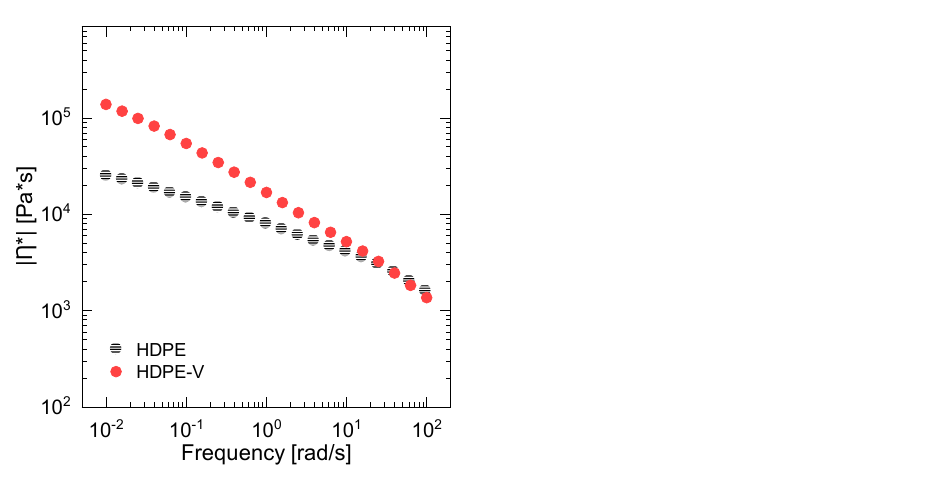
Figure 4. Complex viscosity | η ∗ | as a function of the frequency of HDPE and HDPE-V (220 ◦ C). Figure 4 also reveals the shear-thinning behavior of both polymers. The extent of shear thinning was estimated by fitting the data in Figure 4 to the power-law model (Equation (3)), where K is the consistency index and n is the power-law index. Low values of n indicate a stronger shear-thinning behavior. The calculated values of n of HDPE and HDPE-V were 0.59 and 0.41, respectively. Therefore, the vitrimer has a higher shear-thinning dependency, which is usually desirable in extrusion-based 3D-printing processes. Higher shear thinning is usually desired for two reasons: (1) the polymer extruded through the nozzle (high shear rate) should have high flowability, which translates into low viscosity values; and (2) during the deposition step (low shear rate), the polymer should have high viscosity to hold its shape under gravity and under the layers on top [7,38].